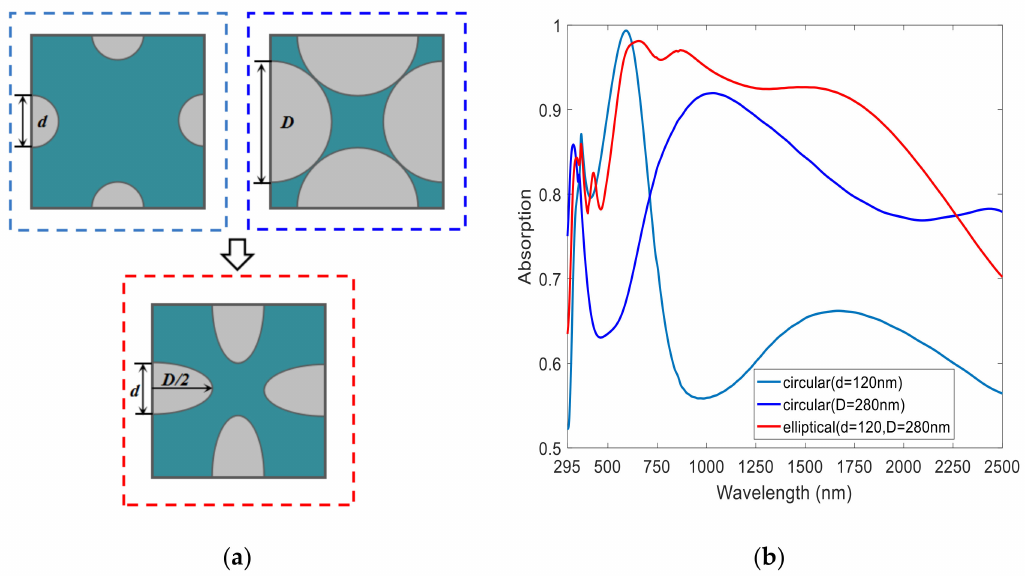
Figure 5. Comparison of the performance of the absorbers under different array patterns. ( a ) Sketch map of circular disk arrays and elliptical disk array. ( b ) Normalized absorption spectra of circular disk arrays and elliptical disk array